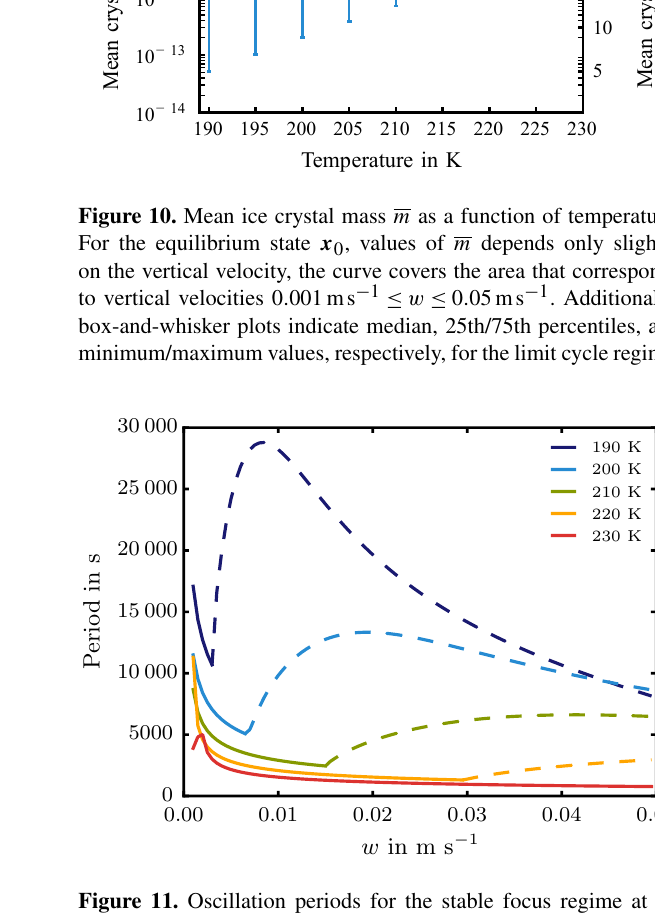
As indicated in Sect. 3.3, the imaginary part of the com- plex eigenvalues λ 1 , 2 determines the period of the oscilla- tions in state 1 (stable focus regime) near the equilibrium point x 0 . In Fig. 11 the period τ = 2 π as calculated from Im (λ 1 , 2 ) the imaginary part is shown for the stable focus (solid lines; colours indicate different temperature regimes). For the un- stable focus, the imaginary part of the eigenvalues is not meaningful, as the limit cycle is not within the linear regime of x 0 . Instead, the periods of the limit cycle is shown (dashed lines; colours indicate different temperature regimes) as cal- culated from the Poincaré map. Note that for decreasing tem- perature the period τ becomes very